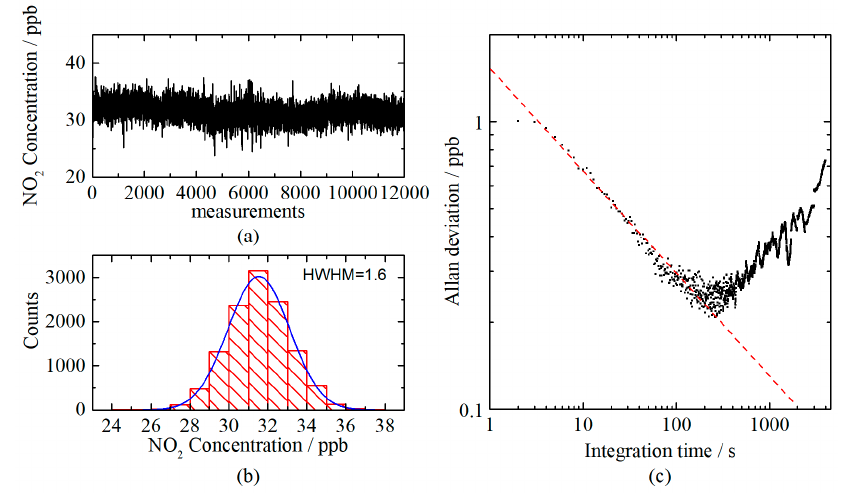
Figure 6. ( a ) Continuous measurements of 31.7 ppb NO 2 ; ( b ) Histogram plot obtained from the measurements. The half width at half maximum (HWHM) of the Gaussian distribution curve is 1.6 ppb; and ( c ) Allan deviation plot of the measurements.